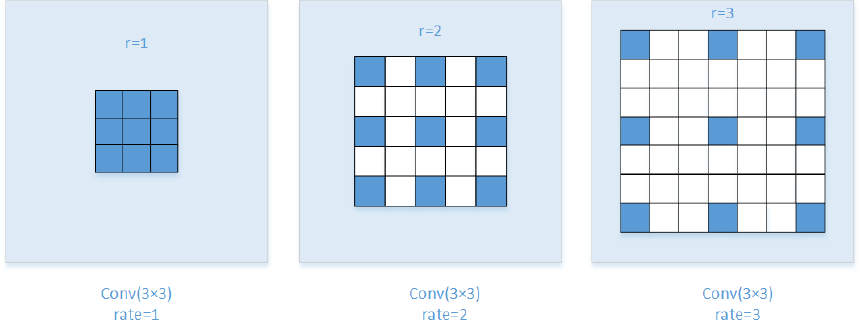
Figure 7. Schematic diagram of dilated